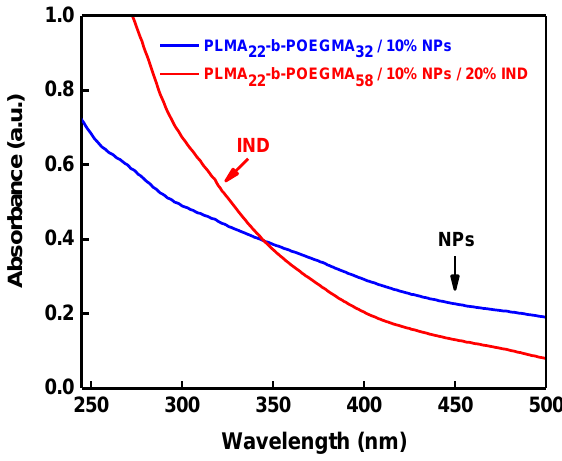
Figure 7. UV–Vis spectra of PLMA 22 -POEGMA 32 /10% NPs (blue line) and PLMA 22 - b -POEGMA 58 /10% Figure UV–Vis spectra of PLMA 22 -POEGMA 32 /10% NPs (blue line) and NPs/20% IND (red line). PLMA 22 - b -POEGMA 58 /10% NPs/20% IND (red line).